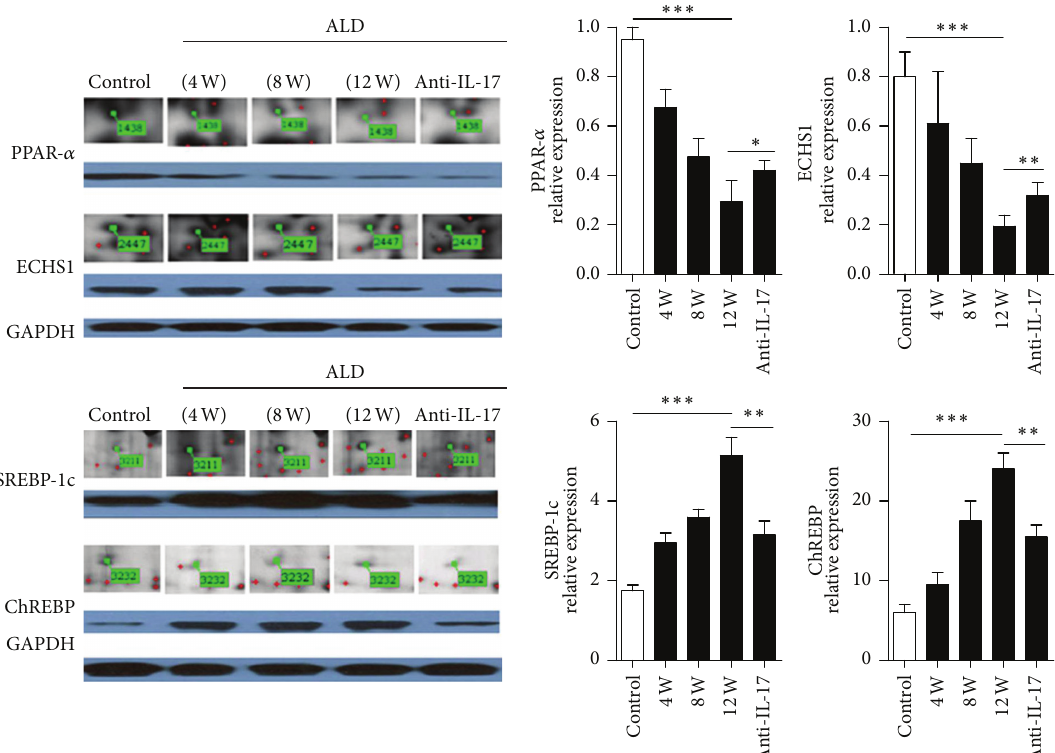
Figure 5: Western blot validation of four selected proteins. Hepatic expression levels of sterol regulatory element-binding protein-lc (SREBP- 1c), carbohydrate response element binding protein (ChREBP), enoyl-coenzyme A hydratase (ECHS1), and peroxisome proliferator-activated receptor alpha (PPAR- 𝛼 ) in the ALD and control groups. The results correlated well with the quantification of the DIGE images, which is also shown. The data indicate Mean ± SEM of five separate experiments. ∗ 𝑃 < 0.05 ; ∗∗ 𝑃 < 0.01 ; ∗∗∗ 𝑃 < 0.001